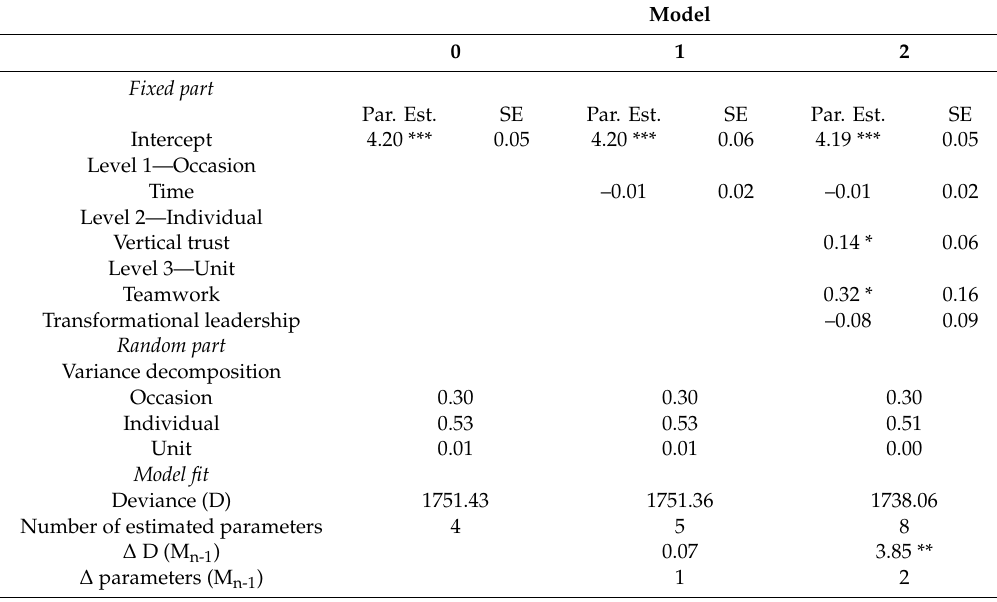
Table 5. Multilevel analysis predicting health from time (Level 1), trust (Level 2), and teamwork and Table